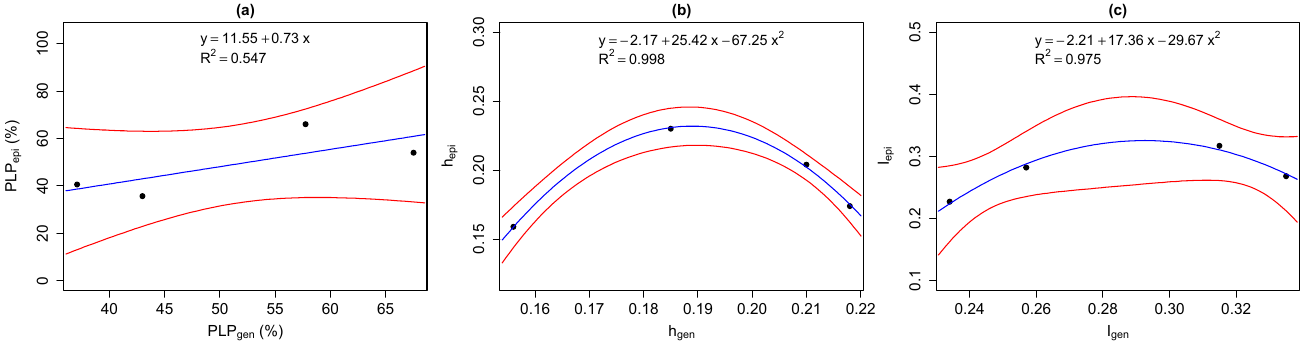
Figure 3. Relationships between intra-population genetic diversity and epigenetic diversity ( n = 4). The dots represent the observed mean values per population, the blue lines represent the model fit, and the red lines correspond to the lower and upper limits of the 90% confidence intervals. The fitted model and the corresponding R 2 are also displayed ( a – c ).